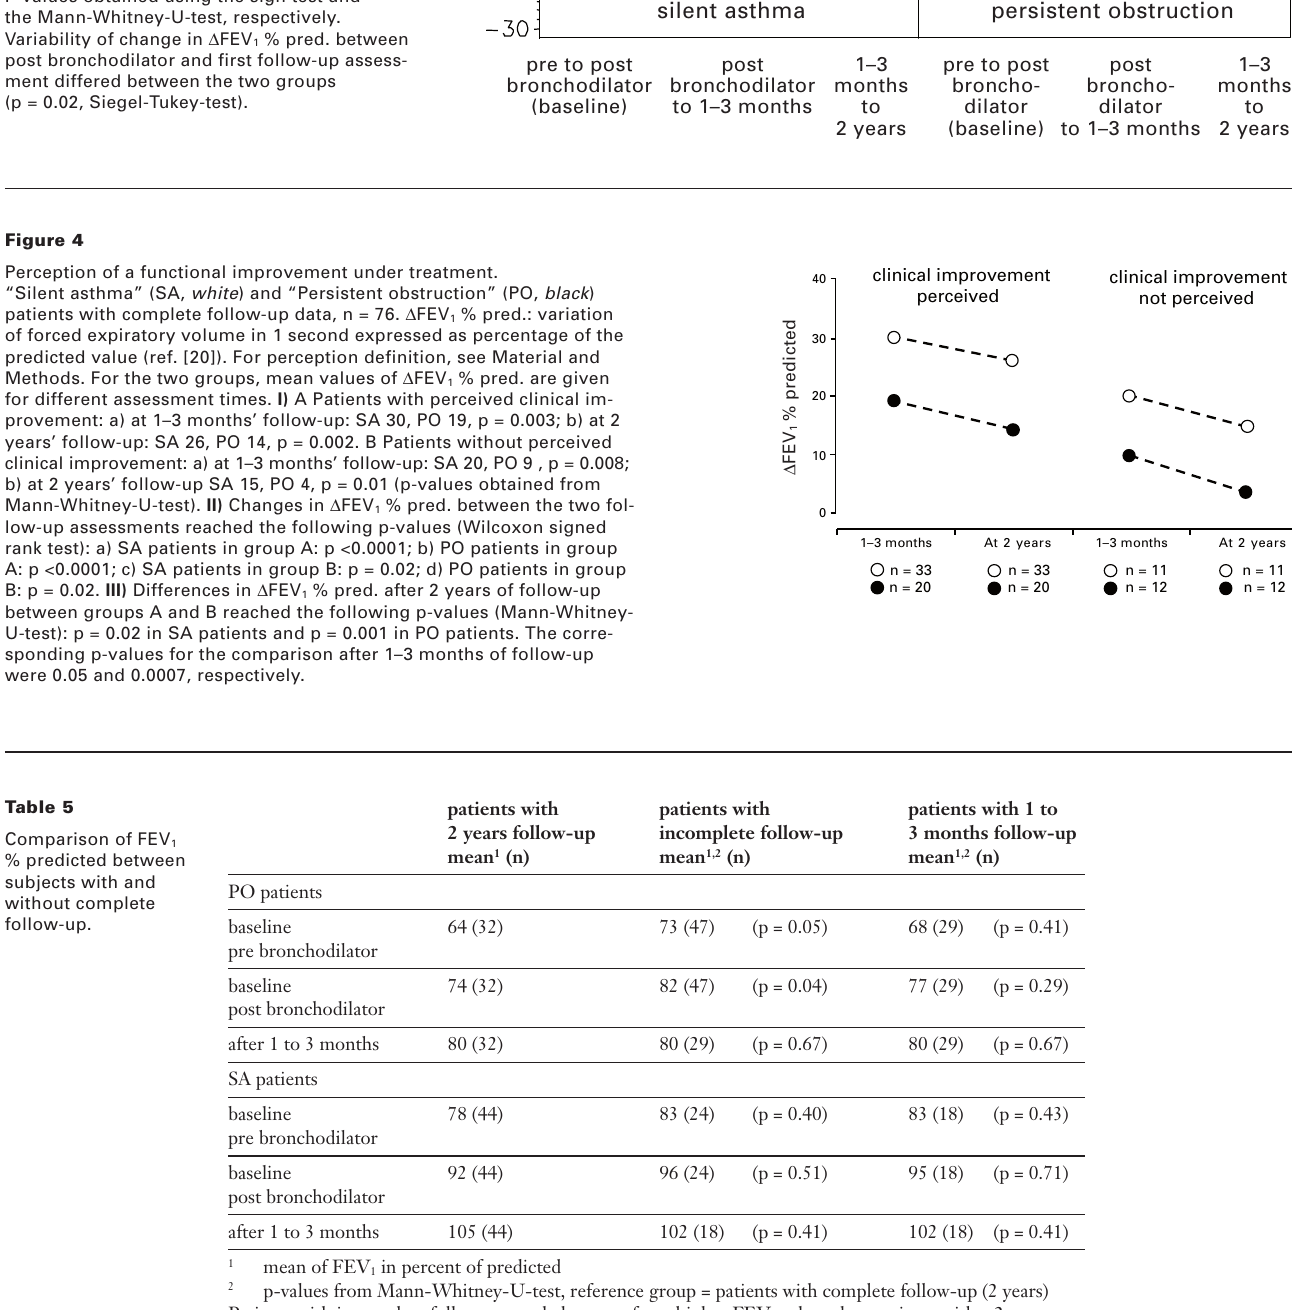
Figure 3 Variability of change in D FEV 1 % pred. between different assessment times. “Silent asthma” (SA) and “Persistent obstruc- tion” (PO) patients with complete follow-up data, n = 76. D FEV 1 % pred.: variation of forced expiratory volume in 1 second expressed as percentage of the predicted value (ref. [20]). For each group, the distribution of the change in D FEV 1 % pred. between different assessment times is represented by three box plots (see figure 2). Observed median changes in D FEV 1 % predicted: a) between initial and post bron- chodilator assessment: SA 13.5, p <0.0001, PO 9.0, p <0.0001, with p = 0.004 for difference